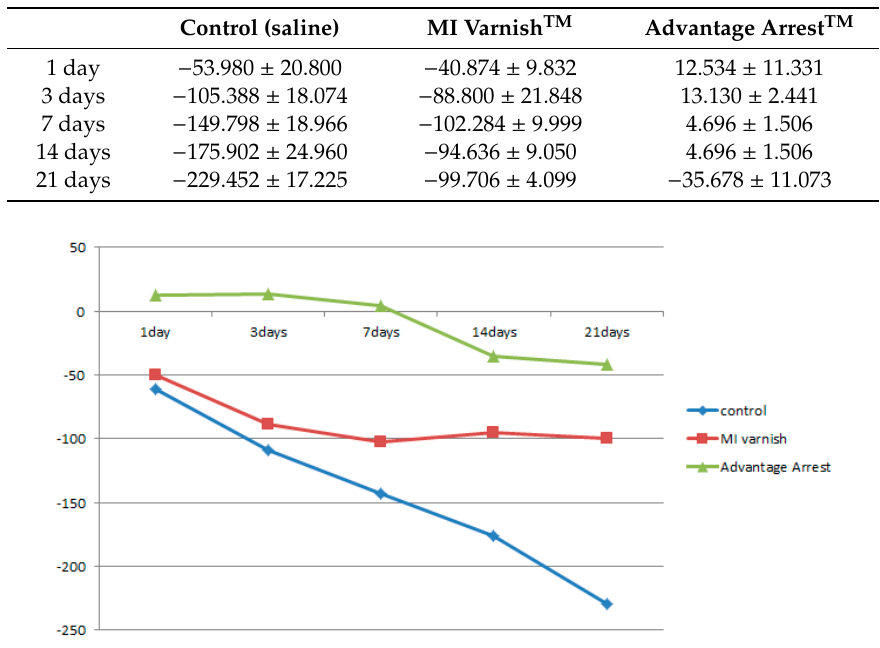
Figure 5. Comparison of ∆ Hounsfield unit value (HUV) of enamel surface between groups at each time.